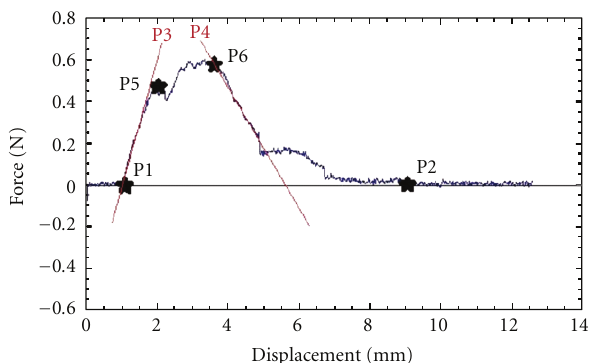
Figure 1: Tensile strain curve: localization of the points “asterisk” P1, P2, P5, and